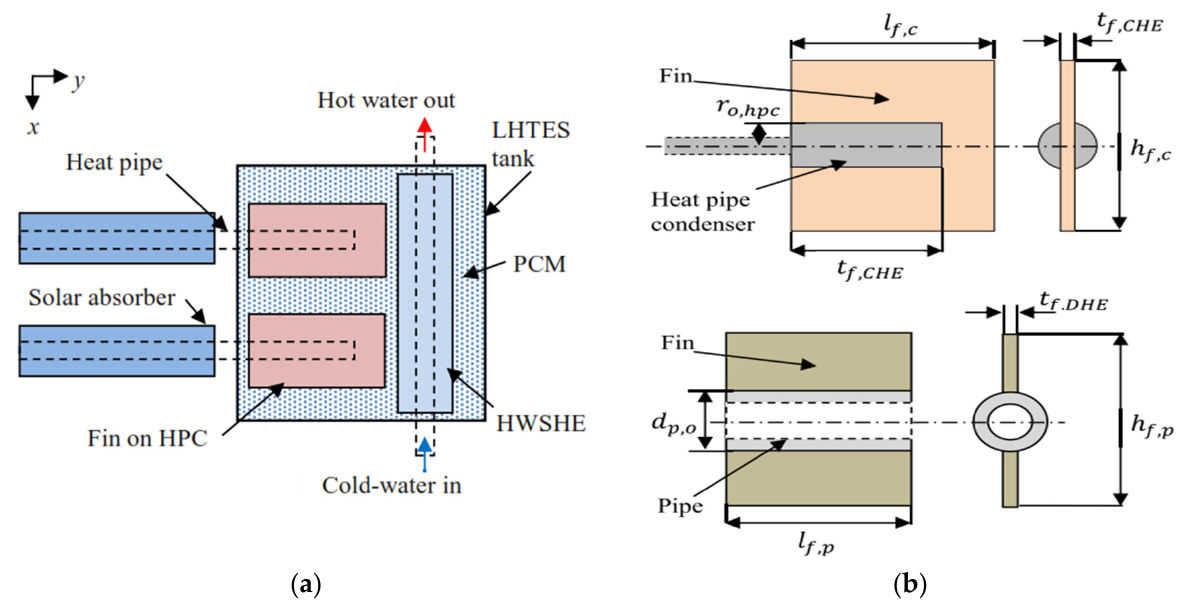
Figure 4. ( a ) ETHPSC-LHTES system studied in [14]; ( b ) fin design for condenser section ( top ) and water pipe ( bottom ).